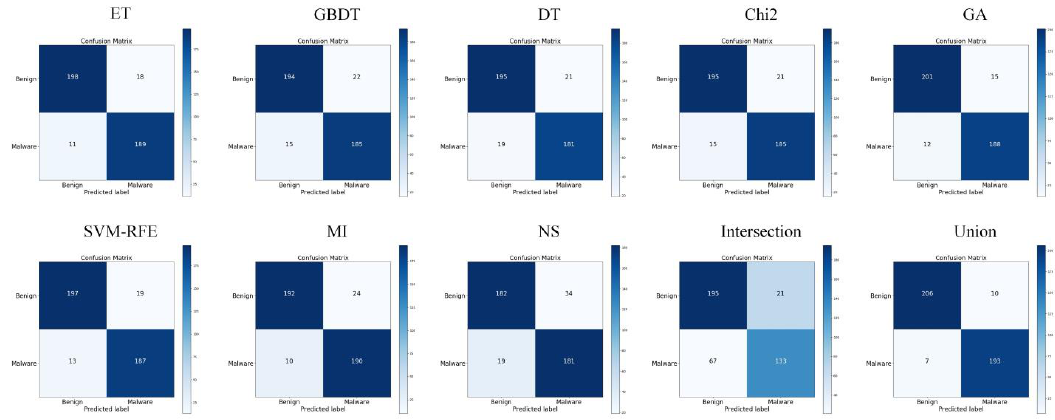
Figure 5. ROC curves of different feature selection methods on our dataset.